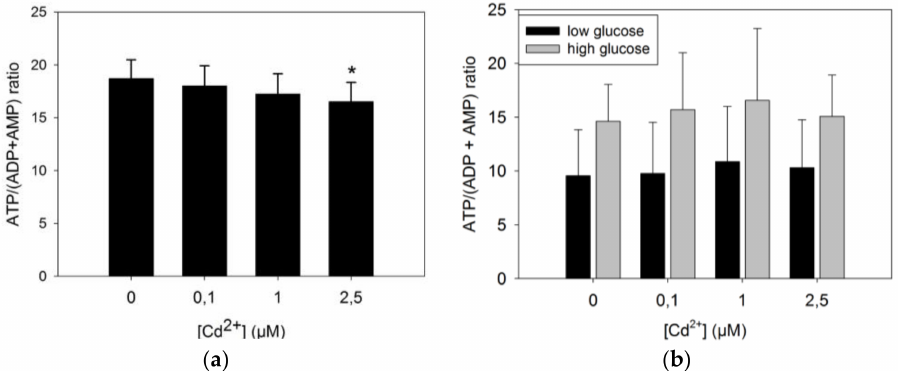
Figure 5. ATP/(ADP + AMP) ratios in INS-1 cells exposed to cadmium. ( a ) INS-1 cells were exposed to the indicated concentrations of cadmium for 72 h in the complete growth medium, and the cellular concentrations of nucleotides were measured as described in Section 2.4. A t -test was applied to compare each group to the non-exposed one. * p = 0.02, n = 9 for each group; ( b ) After the cadmium treatment, cells were pre-incubated for 1 h in KRBH buffer supplemented with 2.8 mM glucose, and then for another hour in the same medium (black bars) and with 16.7 mM glucose (grey bars); n = 7 for each group.